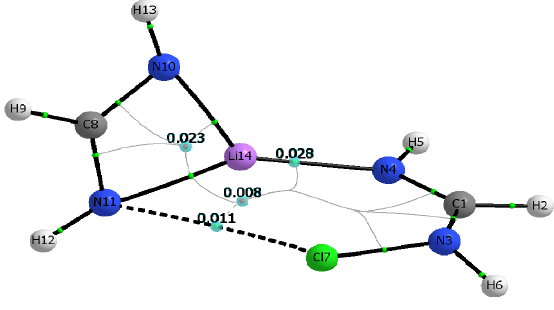
Figure 3. Molecular graph of the C symmetry dimer of chlorinated formamidine and 1 lithium formamidinate. Bond critical points, ring critical points, and bond paths are shown. Molecular graph obtained using B3LYP/aug-cc-pvtz wavefunction obtained from the M06-2X/aug-cc-pvtz optimized dimer.